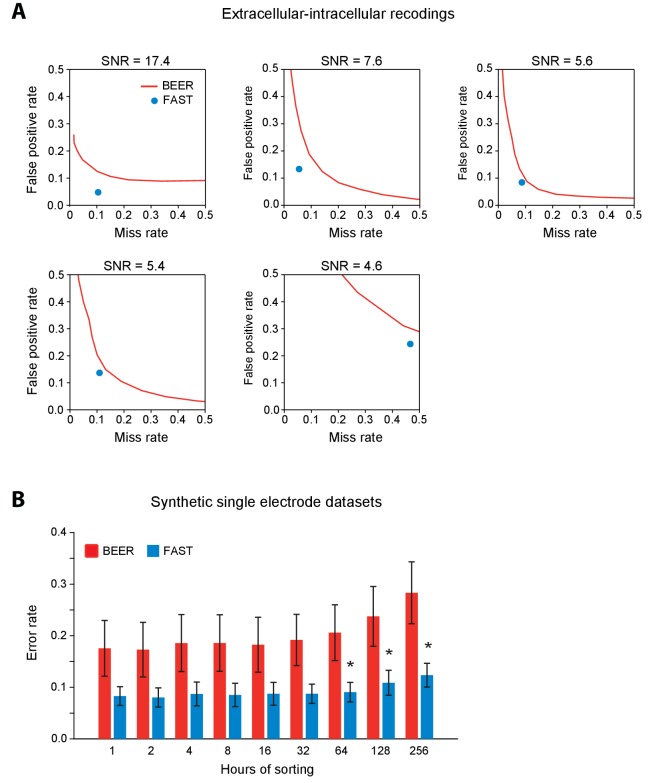
Validation of spike-sorting performance of FAST using ground-truth extracellular-intracellular recordings and synthetic single electrode datasets.(A) Comparison of spike-sorting performance of FAST (blue dots) and BEER (best ellipsoidal error rate, red lines) on 5 different units from the extracellular-intracellular recording datasets of (Henze et al., 2009). Each plot shows the false positive versus miss (false negative) rate in clustering spikes of individual units in comparison to ground-truth. For BEER, we varied the relative misclassification cost of false-positive and miss errors in order to obtain a performance curve. SNR refers to the average signal-to-noise ratio of unit spikes in each recording. (B) Spike-sorting error rate of FAST (blue bars) applied to synthetic single electrode recordings with simulated amplitude drifts (n = 16 units from eight electrodes), in comparison to the BEER measure (red bars) over different durations of the simulated recordings ranging from 1 to the full 256 hr. Error-bars represent standard error of the mean. * indicates p<0.05 after applying the Šidák correction for multiple comparisons.